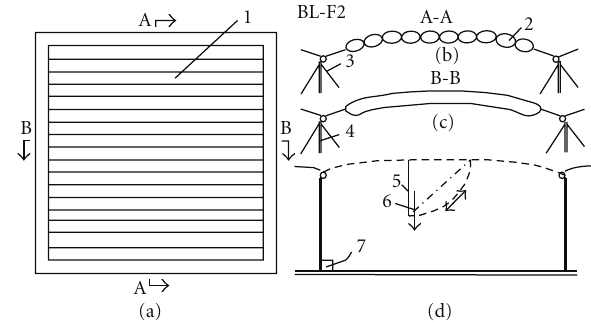
Figure 7: Design of AB Blanket section. (a) Typical section of blanket (top view); (b) cross section A-A of blanket; (c) cross- section B-B of blanket; (d) typical section of AB blanket (side view).